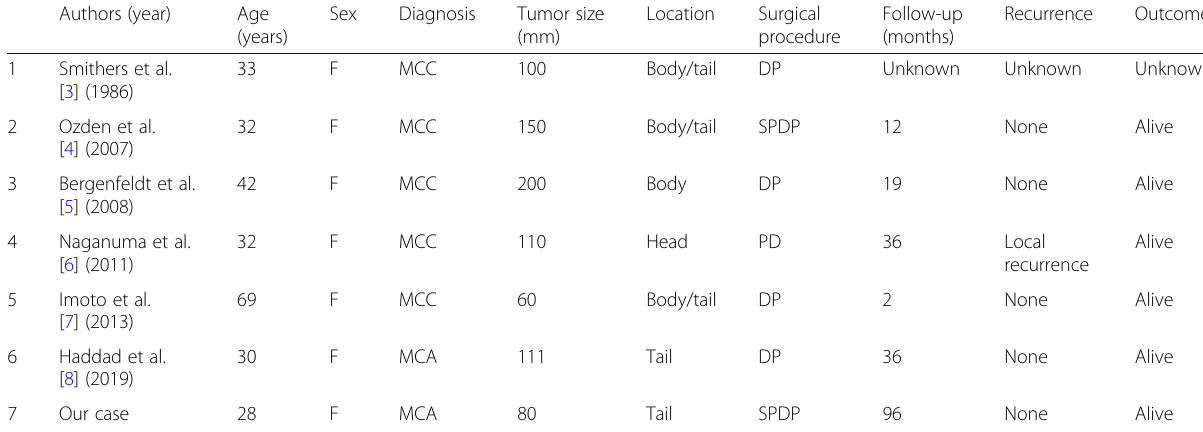
Table 1 Reported cases of ruptured